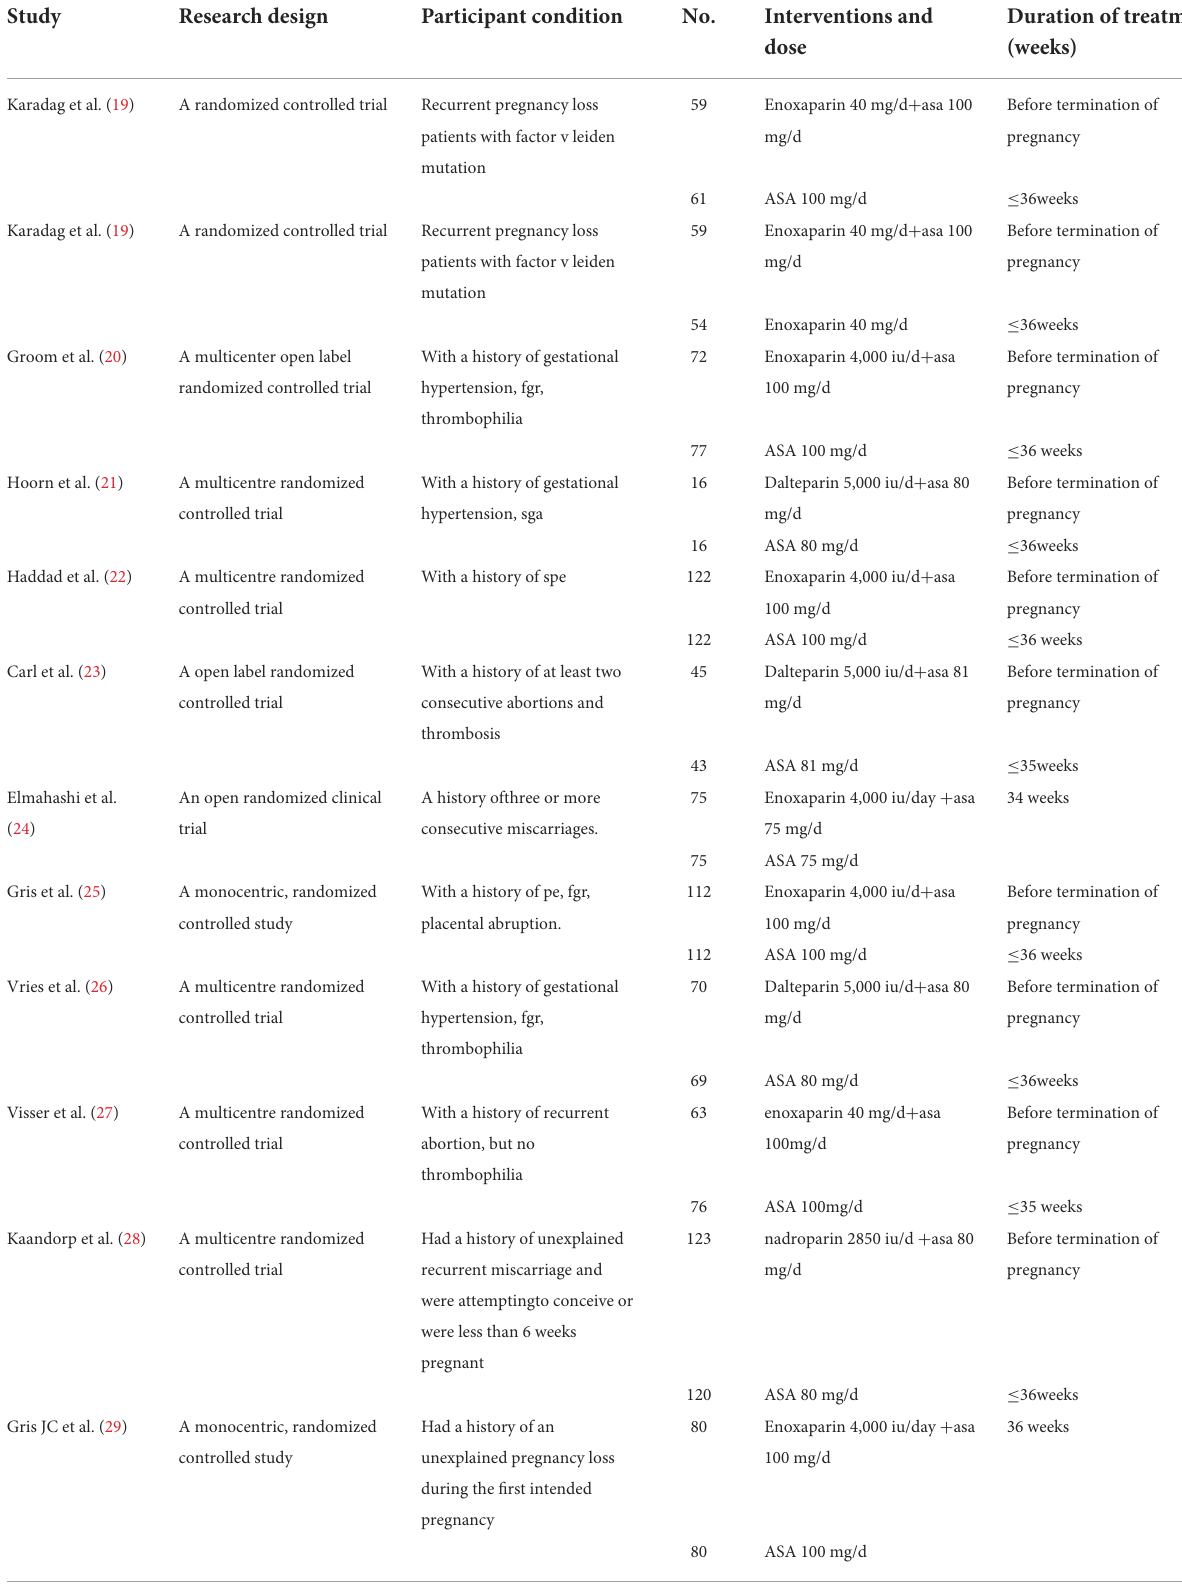
TABLE 1 Baseline characteristics of included studies in the